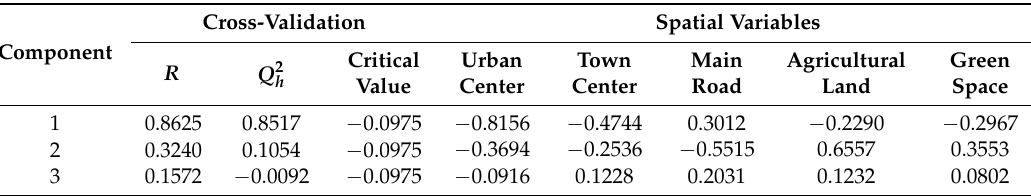
Table 3. Principal components derived from PLS.